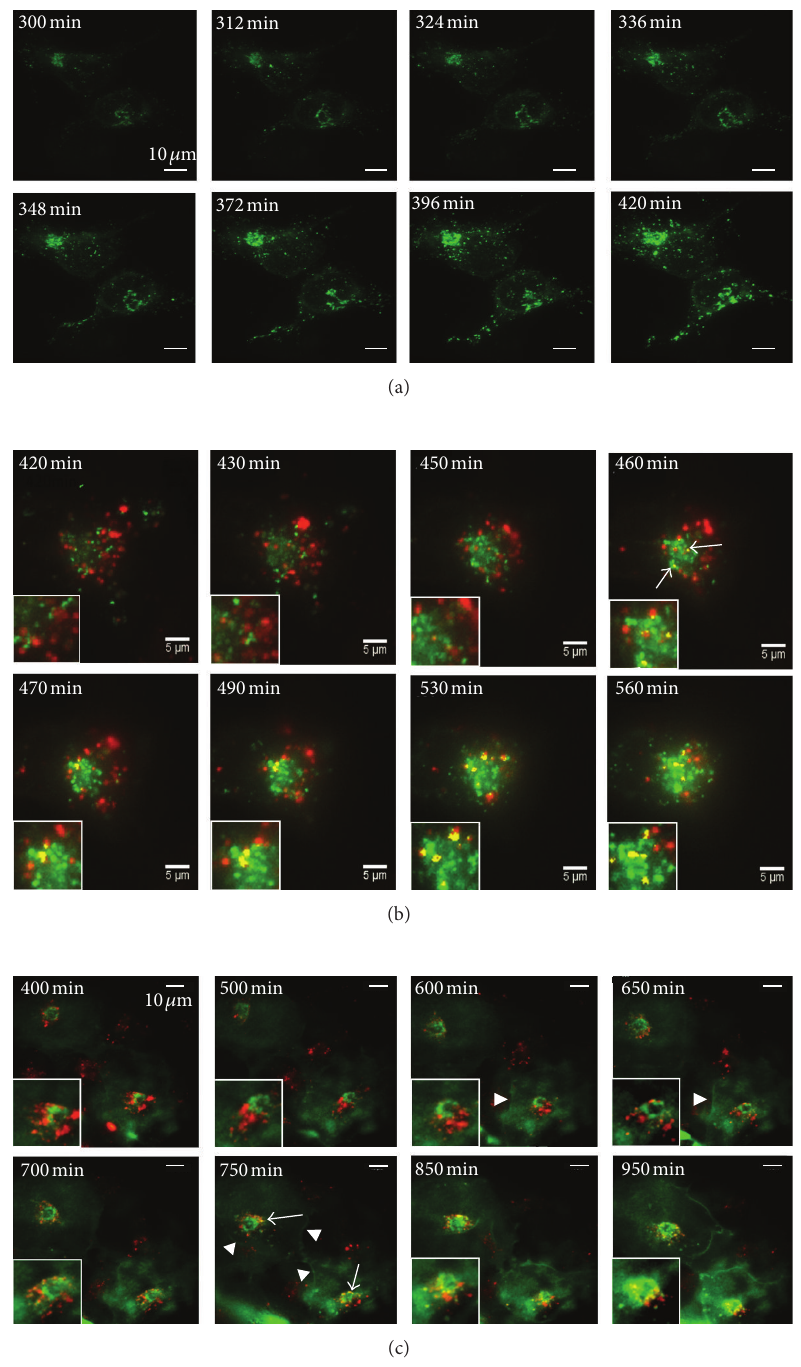
Figure 3: Time-lapse photomicroscopy of PrP::GFP trafficking to lysosomes. (a) At 𝑇 = 0 COS-7 cells were transfected with Mut-PrP::GFP over 3 h, the media were replaced, and imaging started. (a) displays frames of live video collected from 𝑇 = 300 min (5h) to 420 min. Images were extracted as individual frames from supplement Video S1, using ImageJ. (b) Mut-PrP::GFP, as in (a), but in the presence of 30nM LysoTracker Red. Frames were collected between 𝑇 = 420 (7h) and 560 min. Arrows indicate the first appearance of yellow puncta, signifying Mut-PrP delivery to LysoTracker Red positive vesicles. Images were extracted from supplement Video S2. Magnified insets, approximately 2x original image. (c) Wt-PrP::GFP in the presence of LysoTracker Red imaged as in (b) for Mut-PrP, but with a time window of 400 to 950 min, to capture PrP entry into lysosomes. Wt-PrP::GFP is detected on the plasmalemma (arrowheads) prior to its colocalization with LysoTracker Red positive vesicles (arrows), at a much delayed time point than Mut-PrP (750 versus 460 min). Images extracted from supplement Video S3. Magnified insets 4x original image, to compare with